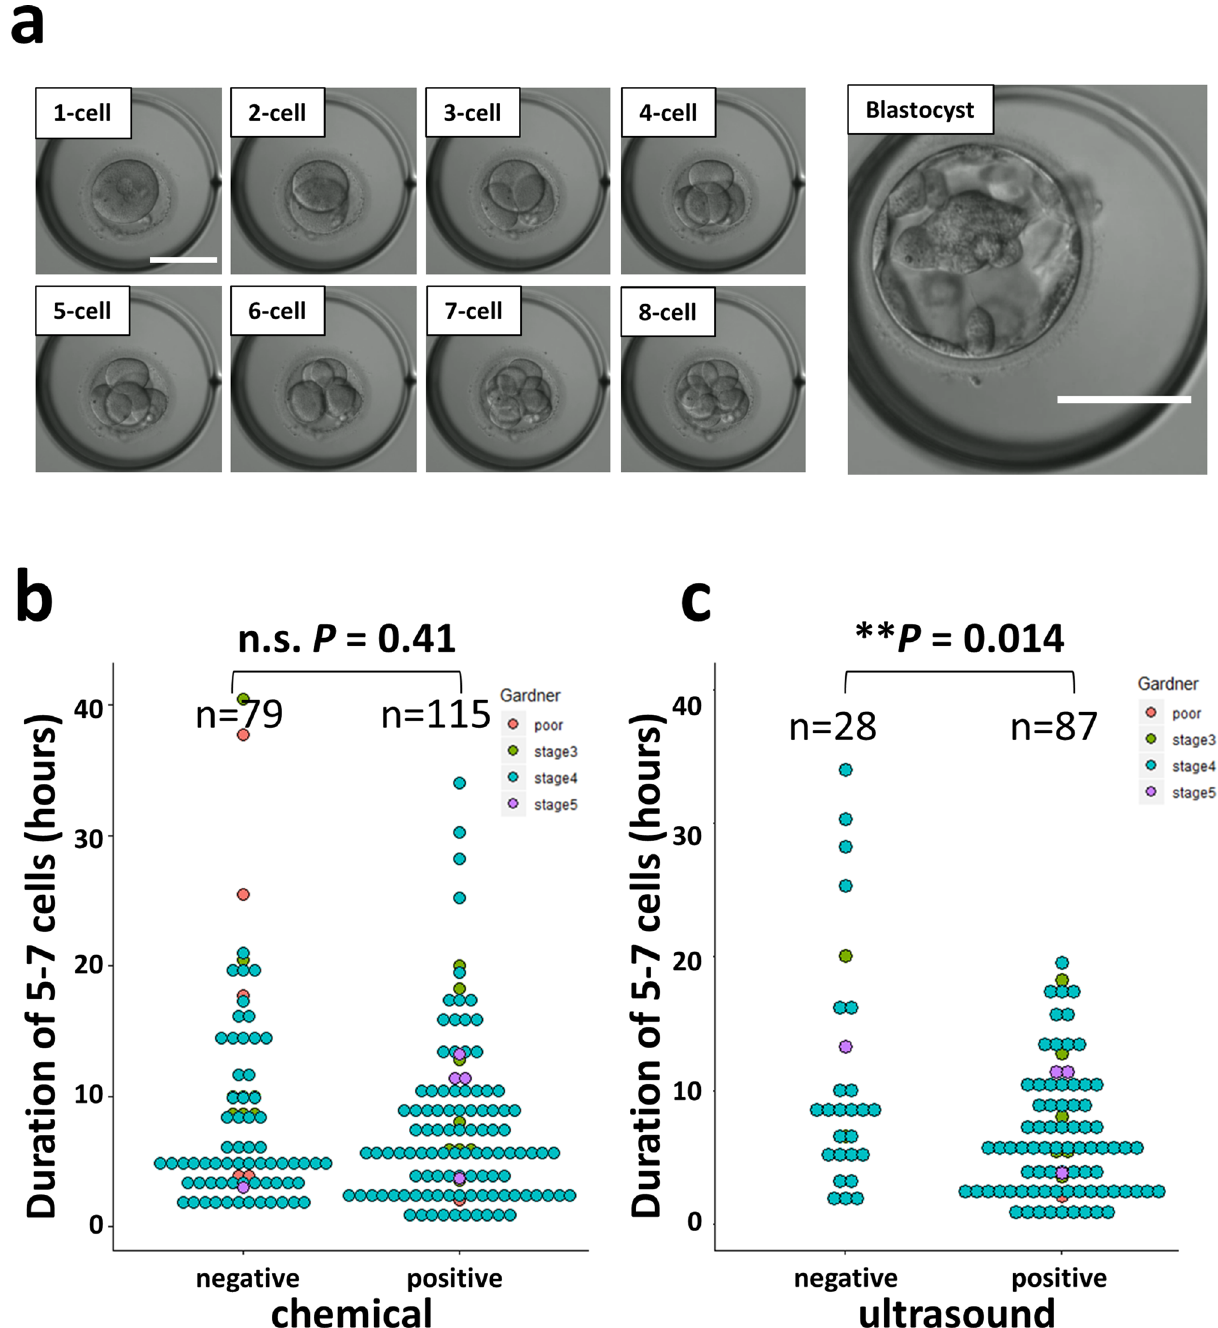
Figure 5. Bright-field observation of human embryos reveals that the third division is related to early abortion. ( a ) Stills taken from movies of human embryos getting infertility treatment were retrospectively analyzed to calculate the time to the 8-cell stage. The embryos growing up to the blastocyst stage were observed and scored by Gardner classification. Bar = 100 µm. In this cohort, 194 human zygotes were analyzed. ( b ) Comparison of duration of 5–7 cells between positive (n = 115) and negative (n = 79) groups of chemical pregnancy tests. (c) Comparison of duration of 5–7 cells between ultrasound-positive (n = 87) and negative (n = 28)